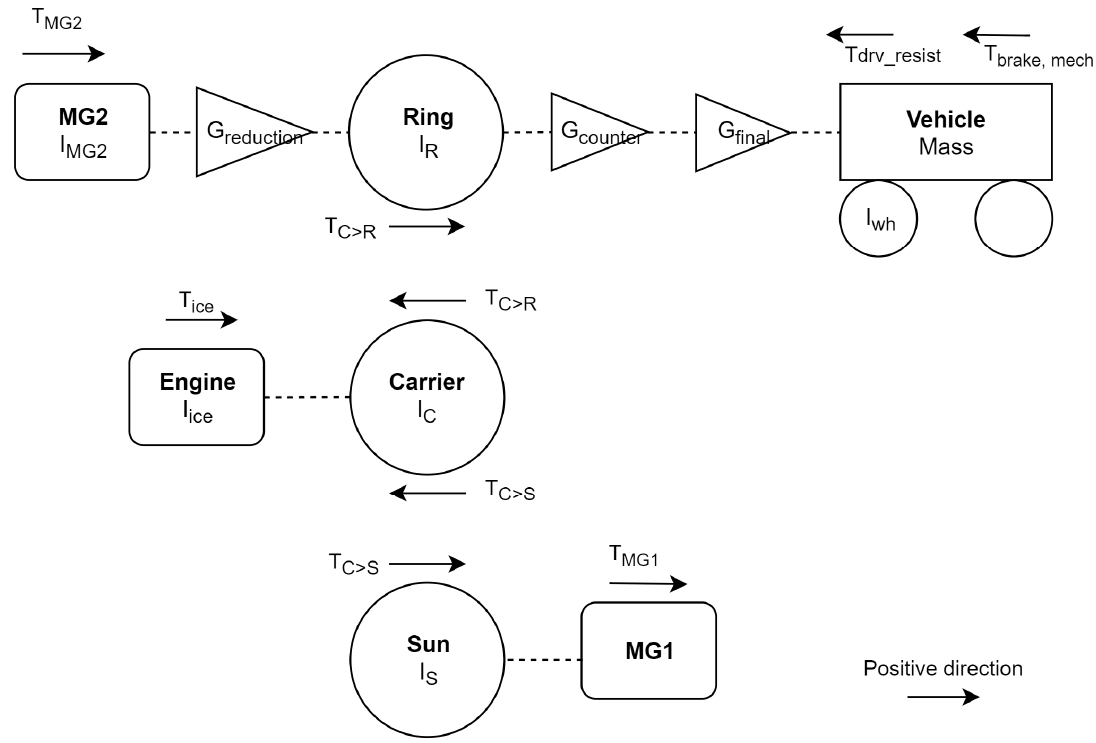
Figure 3. Free-body diagram of Prius3 powertrain.